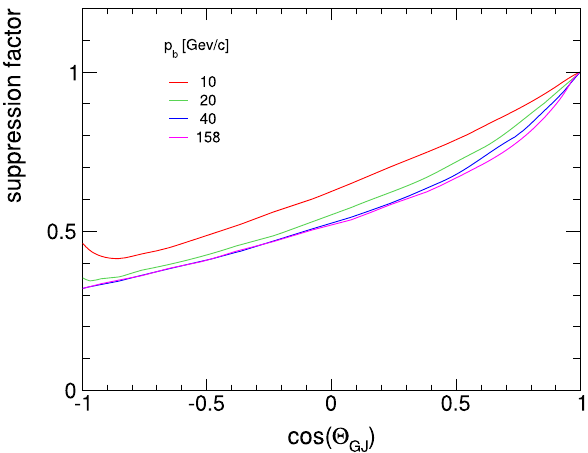
Fig. 163 Measured relativistic Breit–Wigner mass distributions of a Δ (1232) resonance imposing a lab momentum cut on the decay protons at p lab = 1.0 GeV/c for beam momenta between 10 and 158 GeV/c